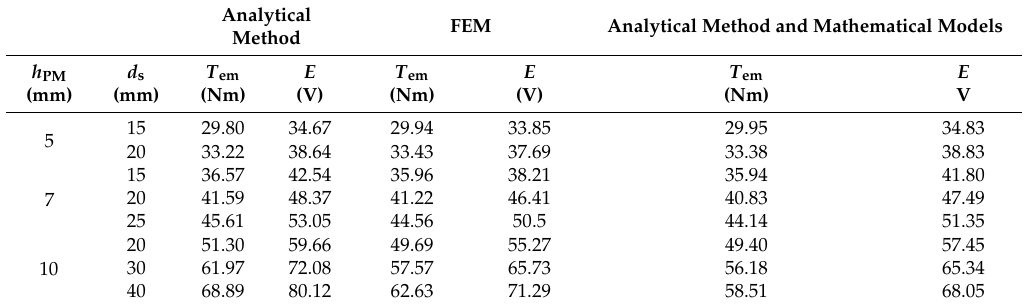
Table 5. Design of 10 pole AFPMSM using FEM and comparison of the results of all three methods.